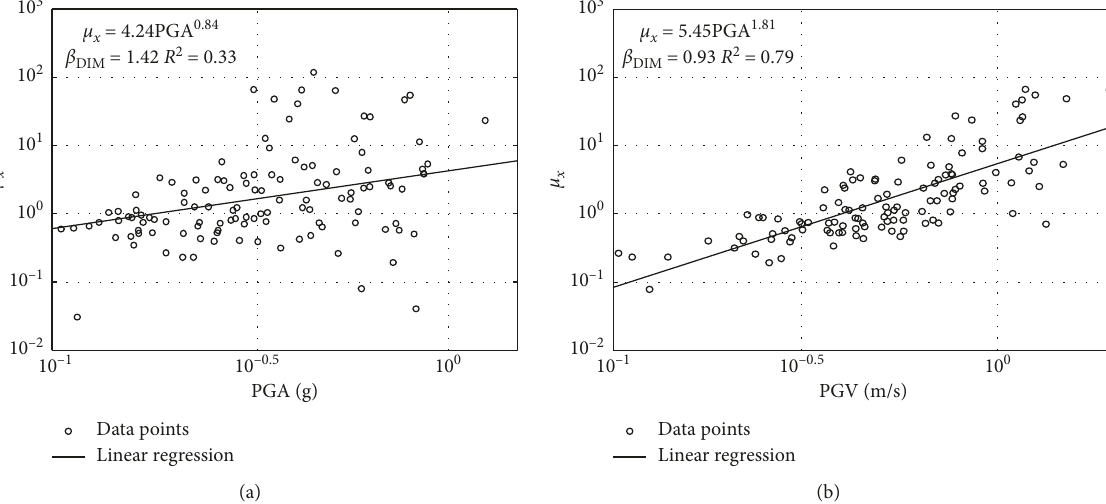
x conditioned on (a) PGA and (b)